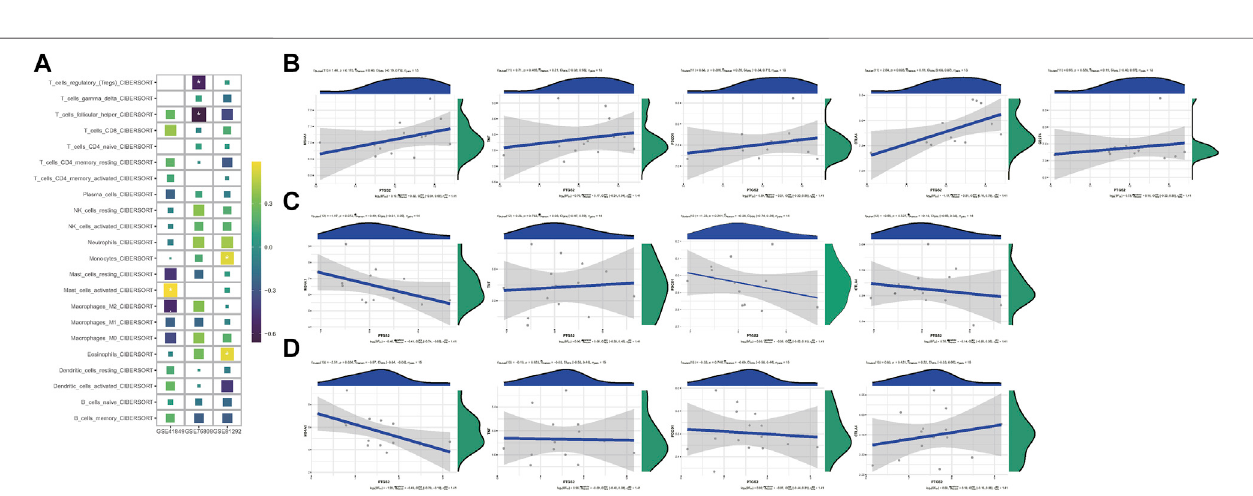
FIGURE 2 | (A) Forest plot of logistic analysis in GSE48149, GSE76808, and GSE81292 datasets. (B – D) ROC curves in GSE48149 (B), GSE76808 (C), and GSE81292 (D) datasets.